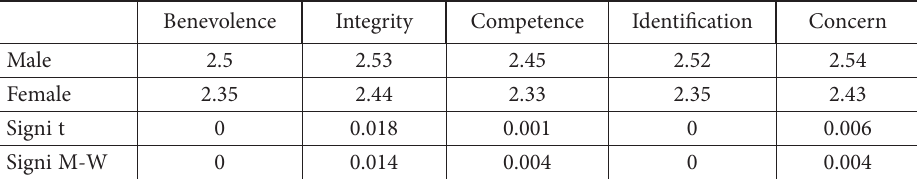
Table 3. Mean trust dimensions scores and significance values: Comparisons by gender (source: own research) Benevolence Integrity Competence Identification Concern Male 2.5 2.53 2.45 2.52 2.54 2.35 2.44 2.33 2.35 2.43 0 0.018 0.001